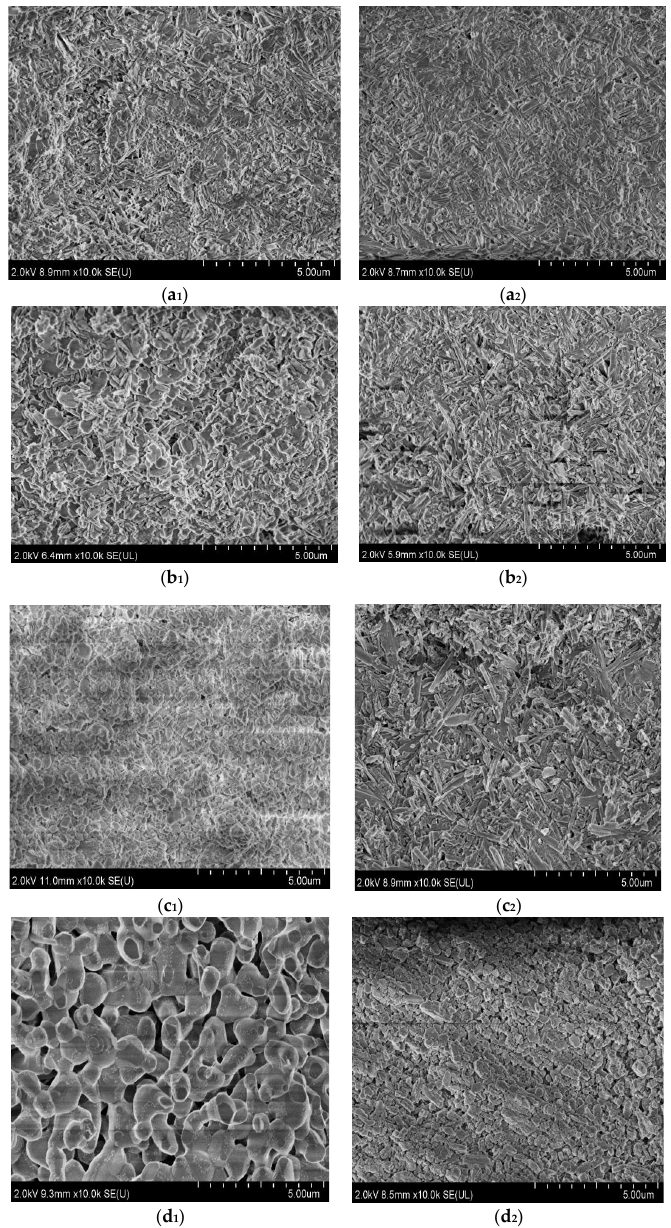
Figure 9. Microscopic morphologies of the surfaces ( a 1 – d 1 ) and inner cores ( a 2 – d 2 ) of the MOC samples after different dry–wet cycles: ( a 1 , a 2 ) without dry–wet cycles; ( b 1 , b 2 ) one time; ( c 1 , c 2 ) two times; ( d 1 , d 2 ) three times. ( a 1 ) Surface layer of sample “a”; ( a 2 ) inner core of sample “a”; ( b 1 ) surface layer of sample “b”; ( b 2 ) inner core of sample “b”; ( c 1 ) surface layer of sample “c”; ( c 2 ) inner core of sample “c”; ( d 1 ) surface layer of sample “d”; ( d 2 ) inner core of sample “d”.